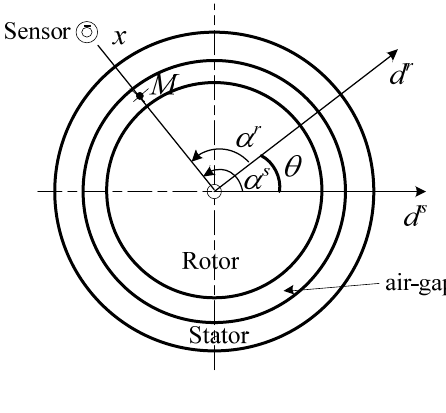
Figure 3. Simplified section of a